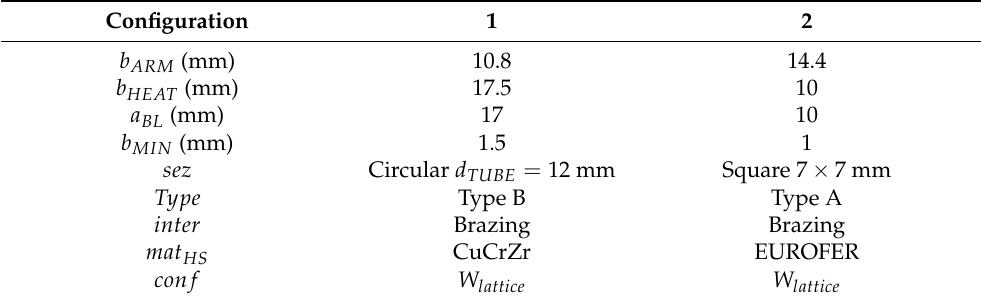
Table 2. Values assumed by the fundamental parameters of the 2D model in the two configurations identified at the end of the optimisation